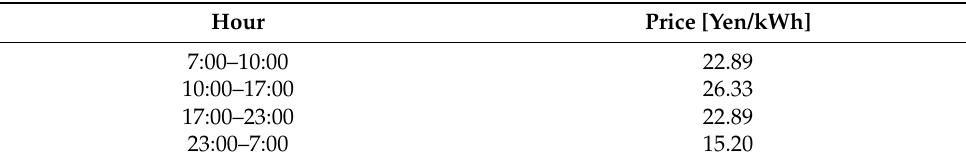
Table 1. Price table of GridPrice t